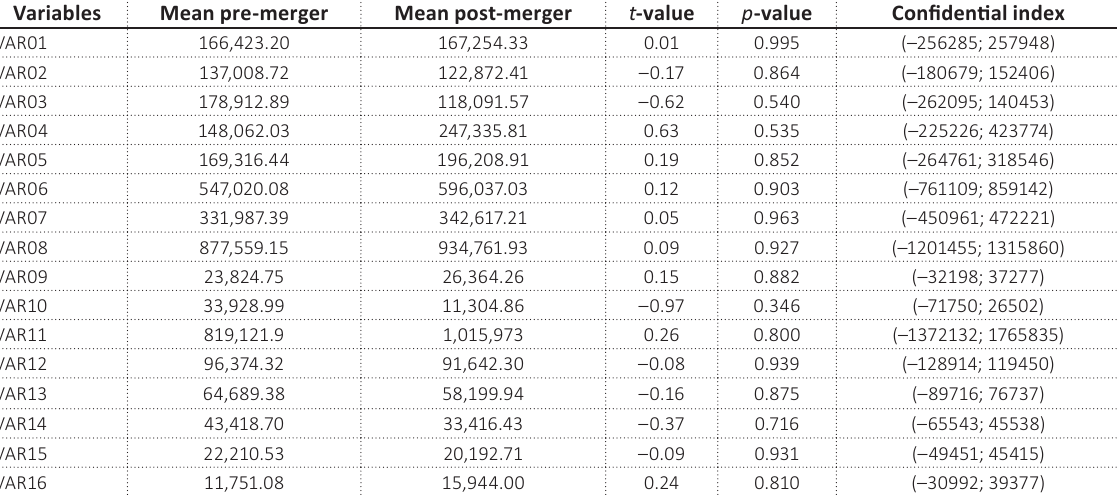
Table 4. Comparison of the mean for 16 accounting measures from pre- and post-merger period